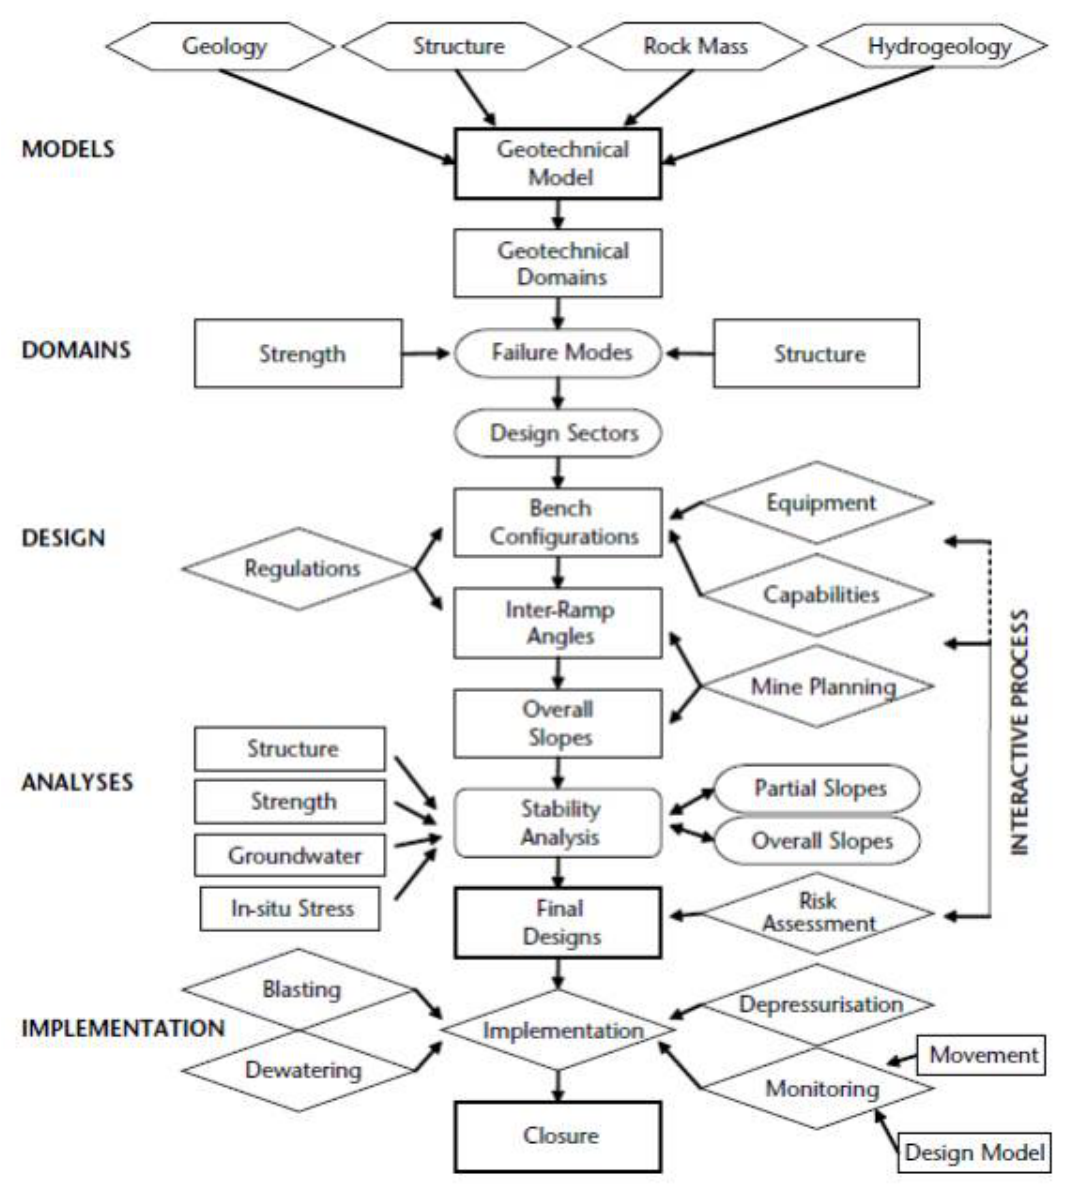
Figure 2. Rock slope design procedure (Adapted from [11]).